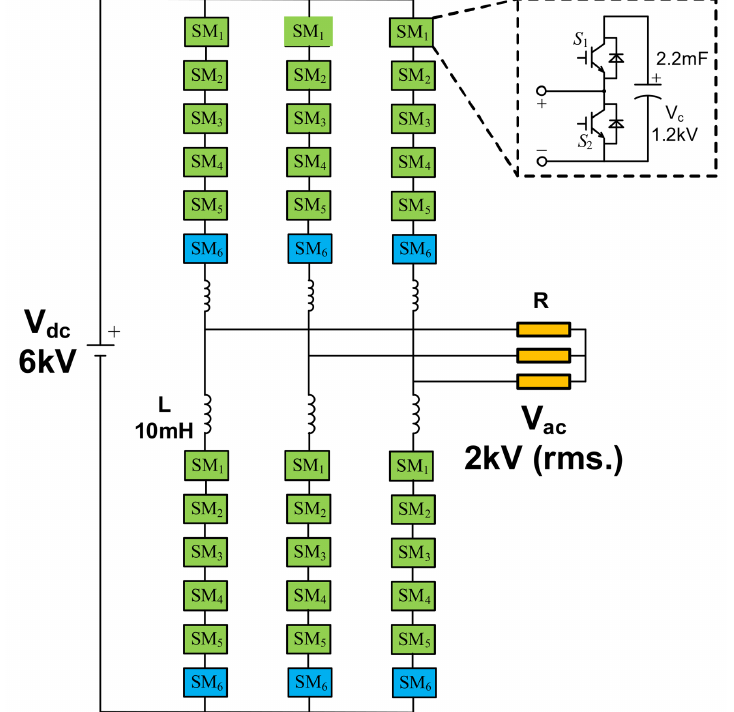
Figure 4. The simulation model.